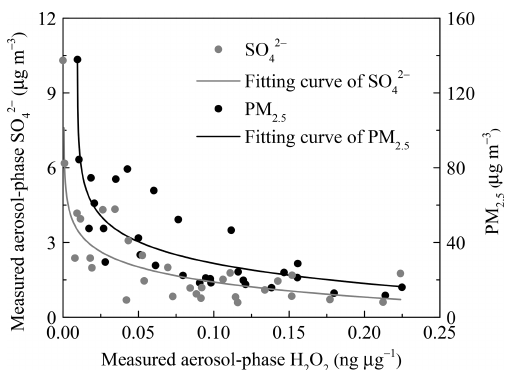
Figure 5. The negative dependence of the measured concentrations of aerosol-phase SO 2 − and PM 2 . 5 on H 2 O 2 . The grey and black 4 lines are the logarithmic fits for SO 2 − level in aerosols and the 4 PM 2 . 5 mass concentration,